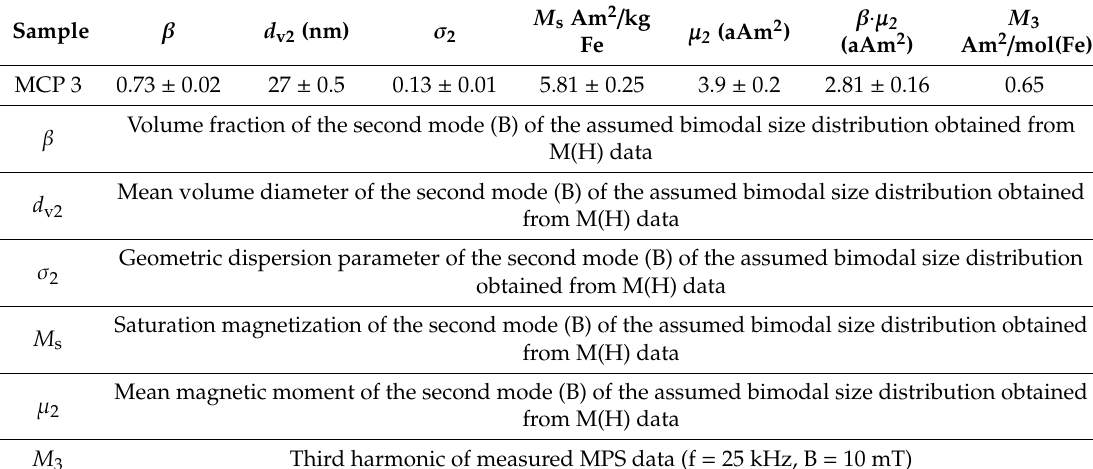
Table 2. Fit parameters obtained from the analysis of the M(H) data.